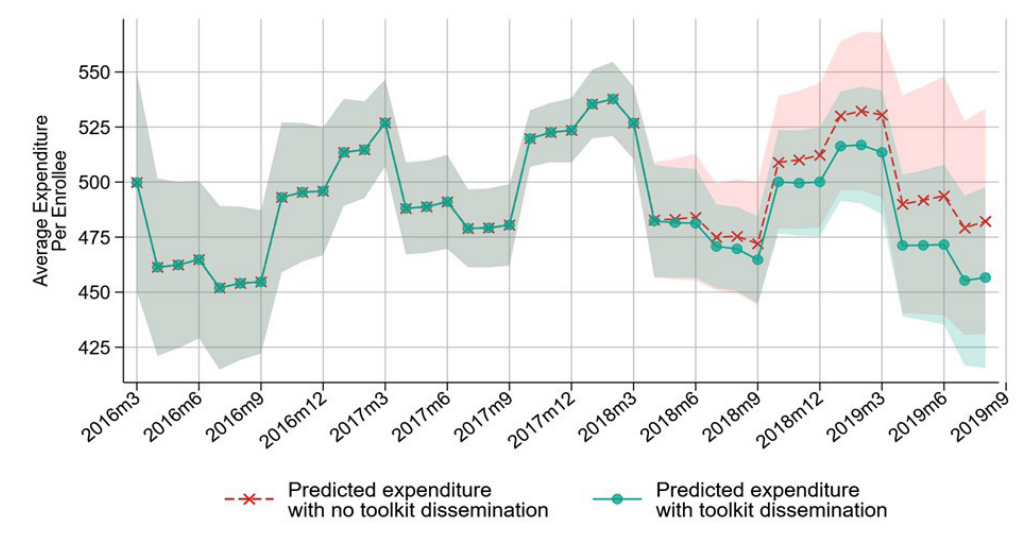
Figure 2. Estimated Change in Total Expenditures after SCD Toolkit Dissemination